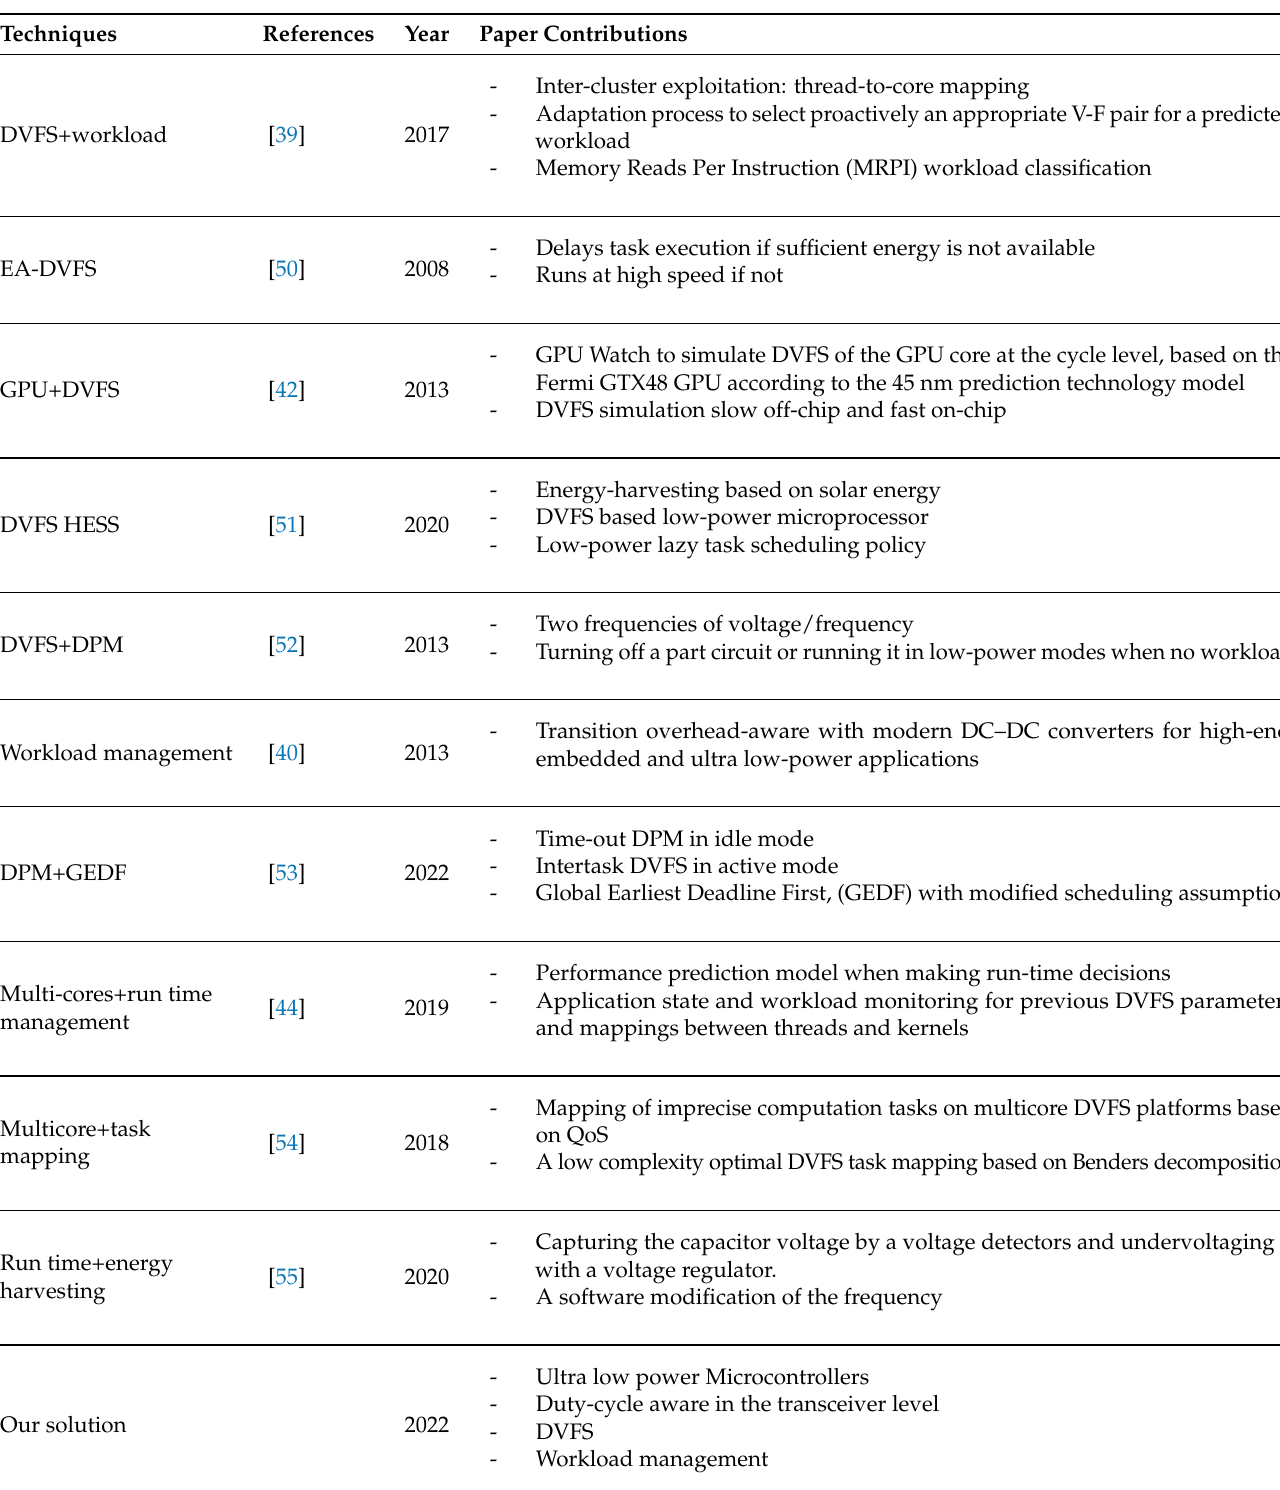
Table 2. WSN-DVFS based techniques’